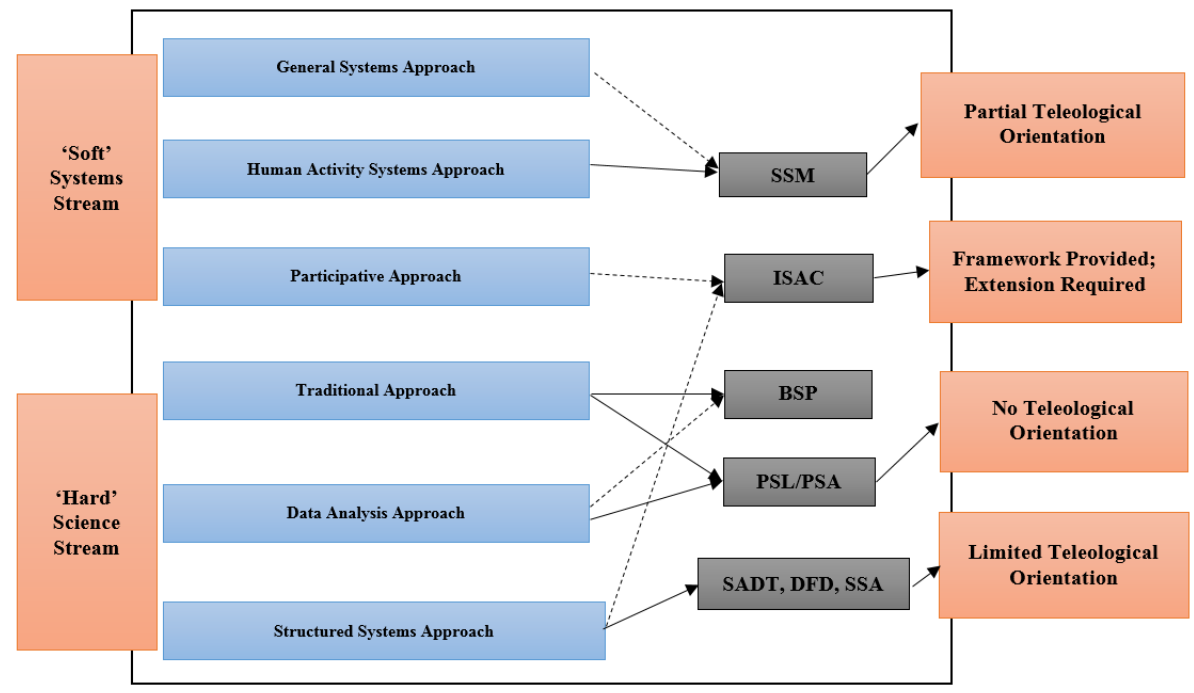
Figure 1. Benchmarking IS development methodologies against the Wood-Harper and Fitzgerald taxonomy of IS analysis and design